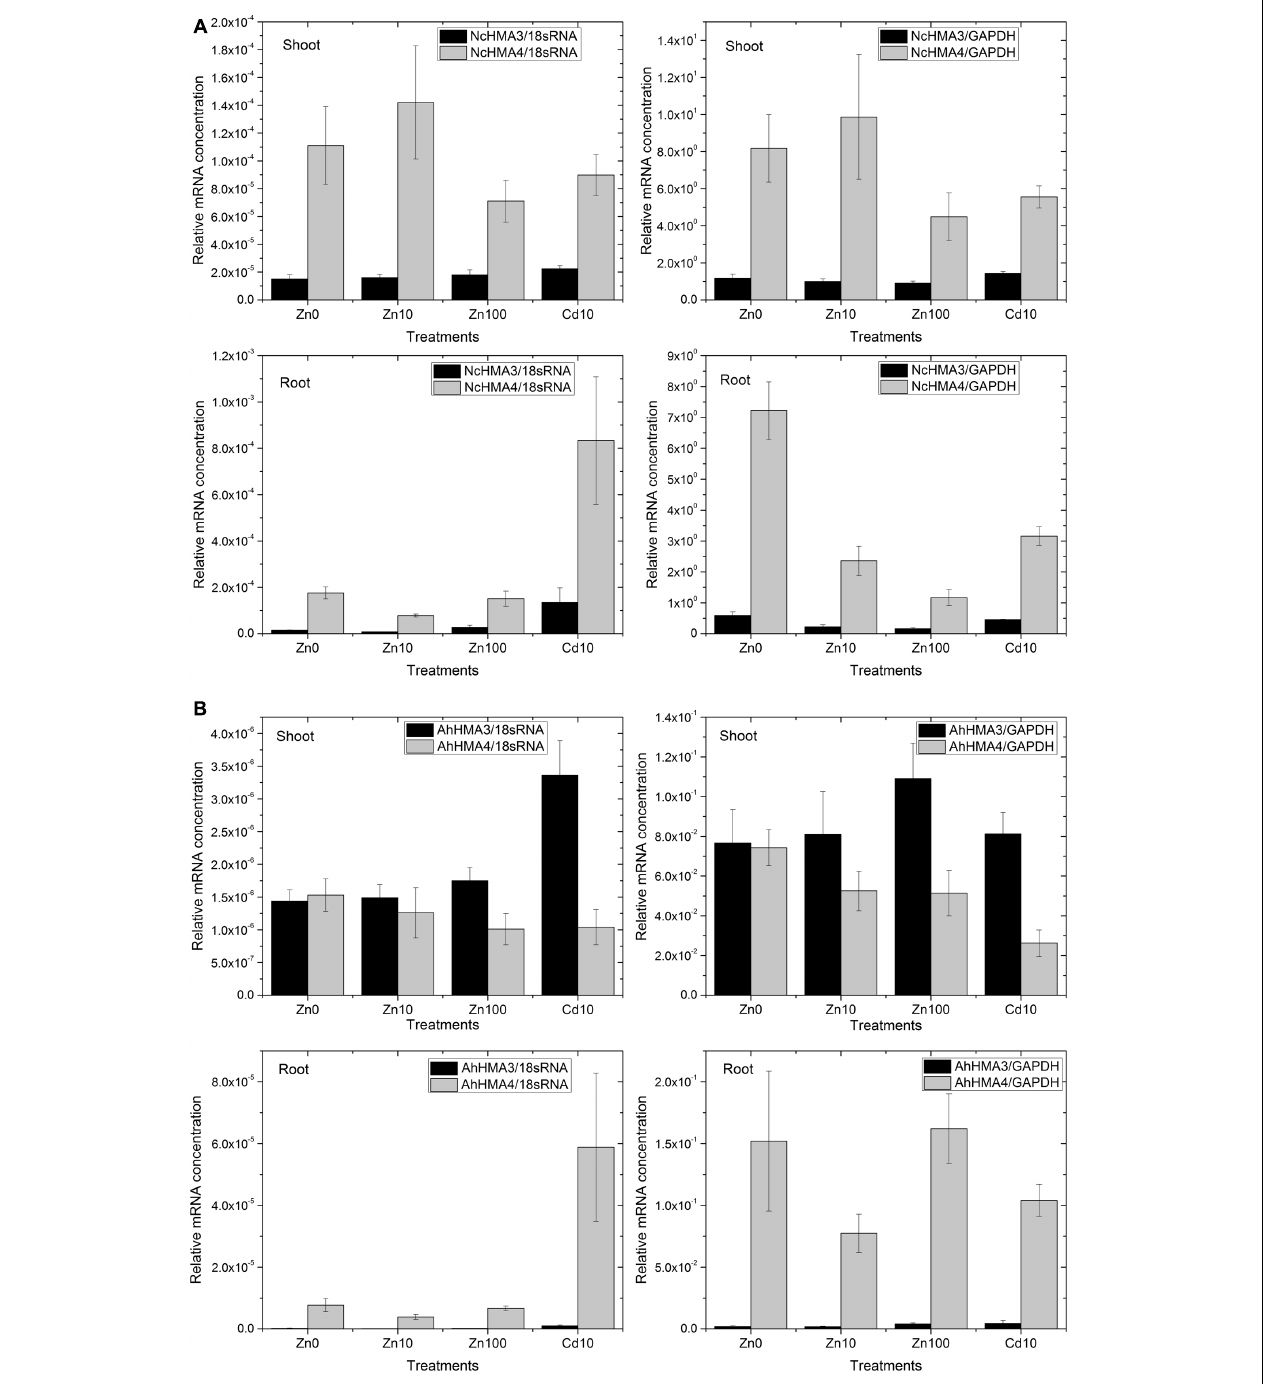
FIGURE 4 | Differential expression of HMA4 and HMA3 in roots and shoots from N. caerulescens (A) and A. halleri (B) analyzed by RT – Real time PCR. The data show the mean ± SE from triplicate samples (different plants within the same experiments) and two representative experiments (i.e., six plants total per